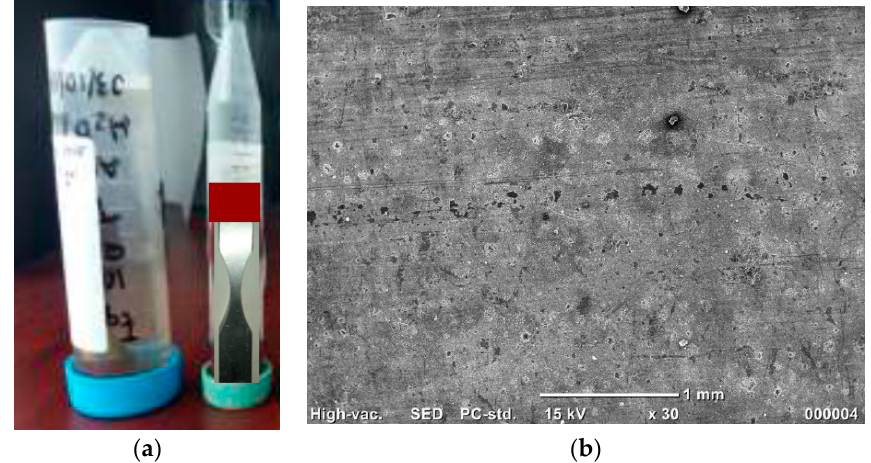
Figure 7. ( a ) Specimens to be machined at the neck section; ( b ) drilling of the two artificial pits holes.